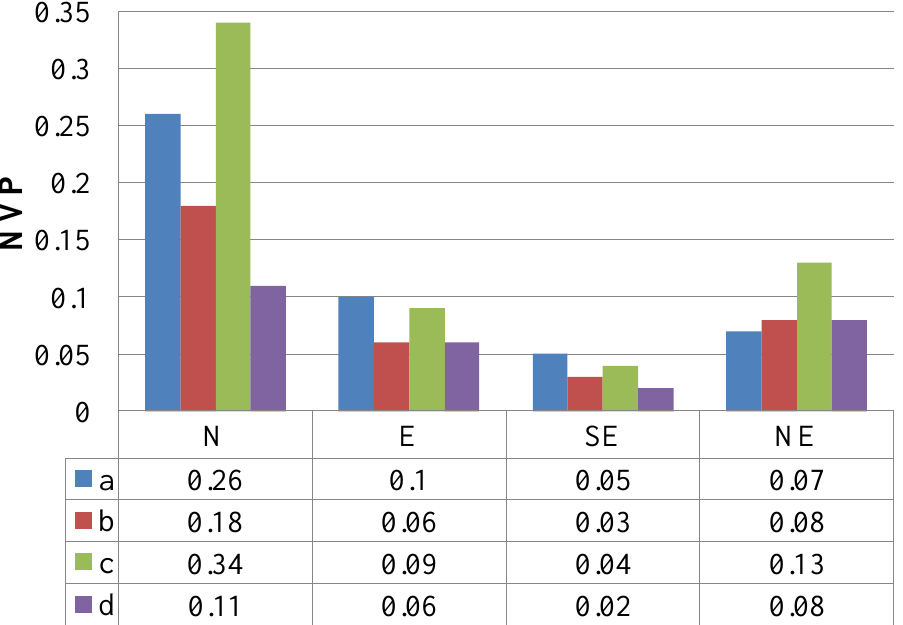
Figure 3. NVP levels at different wind directions for four representative residential areas (a. points layout, b. parallel layout, c. center-around layout, d. mixed layout) (N: North wind; E: East wind, SE: Southeast wind, NE: Northeast wind).